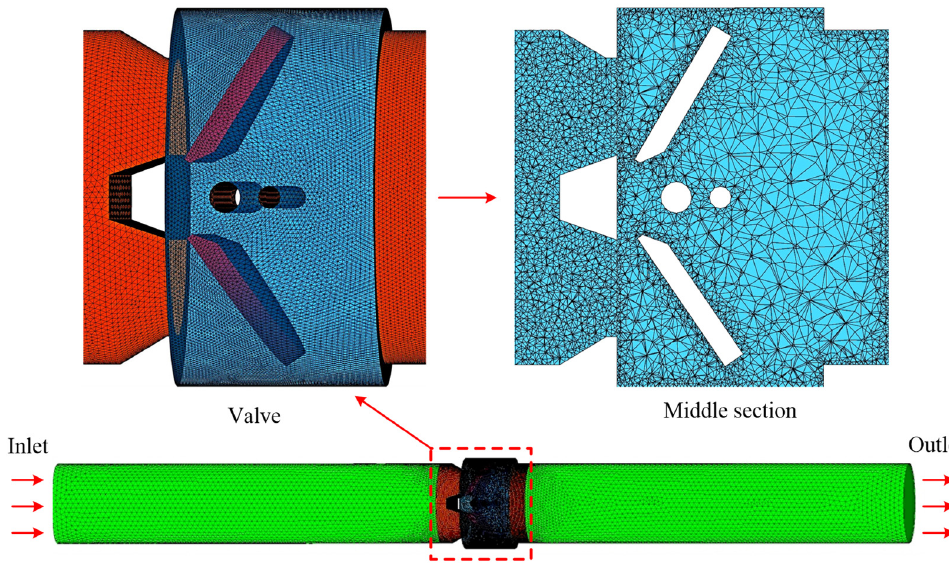
Figure 3. Mesh diagram of the whole 3D fluid domain.